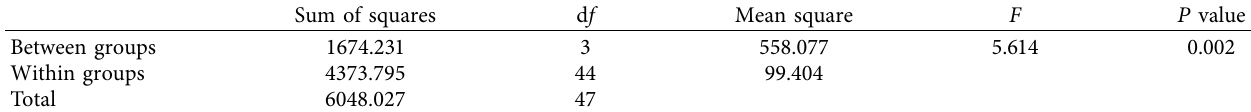
Table 2: ANOVA with different implant positions.